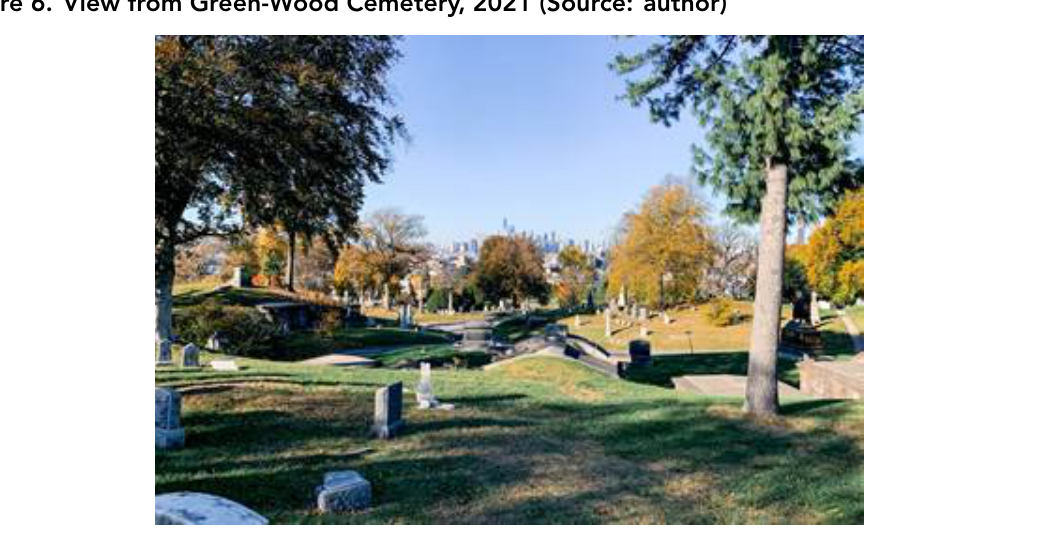
Figure 6. View from Green-Wood Cemetery, 2021 (Source: